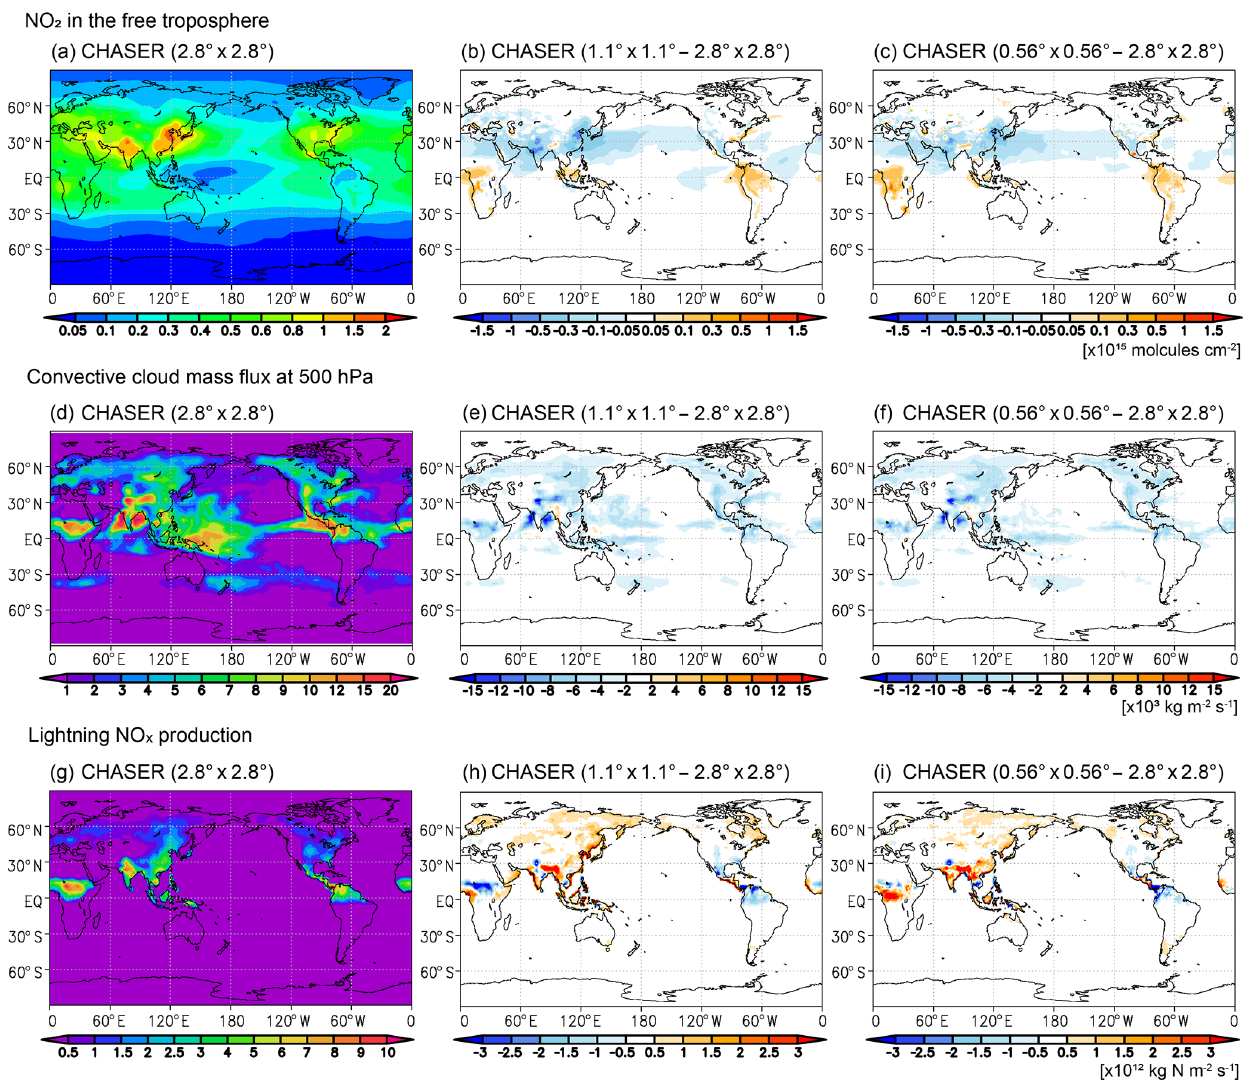
Figure 14. Global distributions of (a–c) NO 2 partial column ( × 10 15 moleculescm − 2 ) integrated from the sixth layer to the tropopause, (d– f) convective cloud updraft ( × 10 3 kgm − 2 s − 1 ) at 500hPa, and (g–i) vertically integrated lightning NO x production ( × 10 12 kgNm − 2 s − 1 ) in the model simulation at 2.8 ◦ resolution (first column) during JJA in 2008 and differences between the model simulation at 1.1 ◦ (second column) and 0.56 ◦ (third column) resolutions and the model at 2.8 ◦